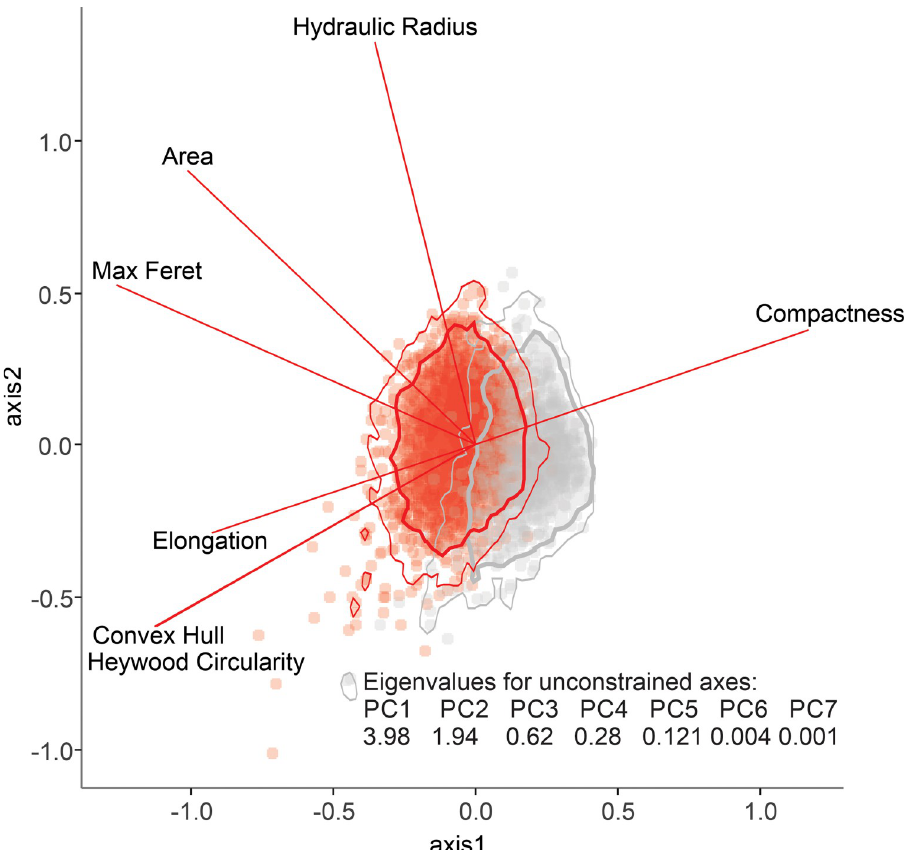
Fig 9. Principal component analysis of the seven core parameters for Leptospermum scoparium and Kunzea pollen in polar view. Polygons show the highest posterior density region for each species, thick lines = 95% range, thin lines = 99% range, calculated using R package coda